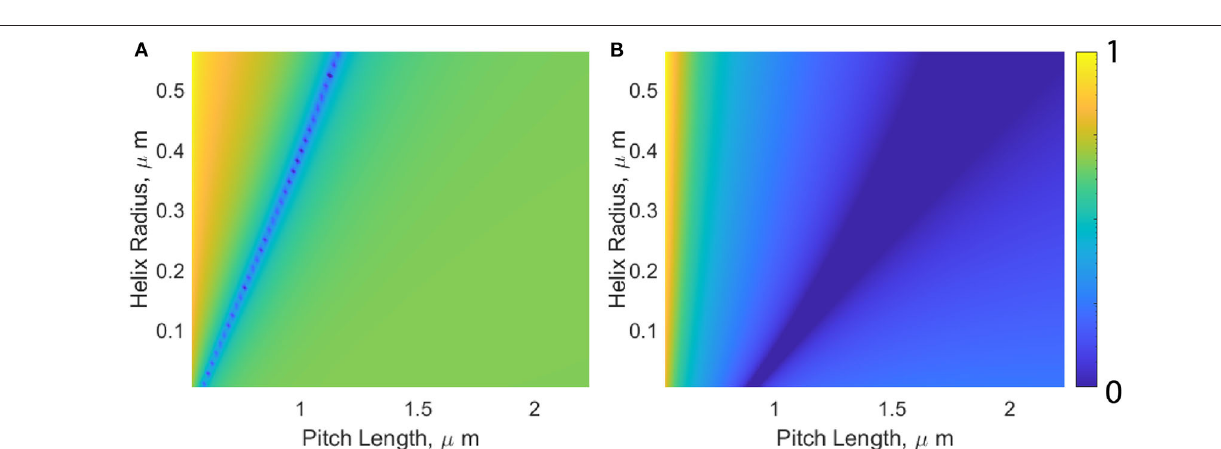
FIGURE 4 | Visualization of how changes in helix pitch length and radius affect the propulsive force produced by the flagellum. The color-bar represents the normalized force difference, where darker colors (0 on the color-bar) indicate which values for pitch length and helix radii will produce the propulsive swimming force generated by a typical E. coli moving through water with a viscosity of η = 0.89 mPas (A) and η = 190 mPas (B)